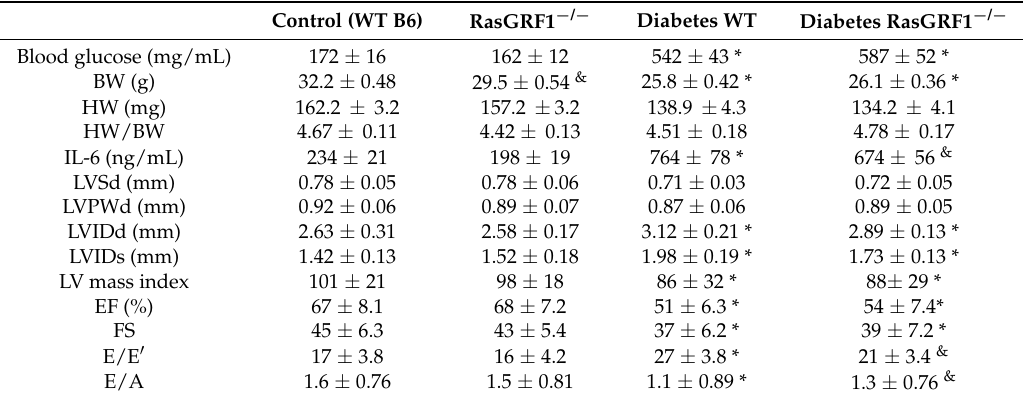
Figure 2. Morphology and cardiac function in mice as measured by cardiac echography. Representative echocardiography ( upper panel ) showed M-mode tracing. Lines indicate left ventricular septum thickness in diastole (LVSd), left ventricular posterior wall thickness in diastole (LVPWd), left ventricular internal dimension in diastole (LVIDd), left ventricular internal dimension in systole (LVIDs), and left ventricle (LV) mass. Pulse wave doppler recordings of mitral valve leaflet tips ( middle panel ) showed mitral inflow velocity patterns, and were also calculated. Representative tracings ( lower panel ) for tissue Doppler imaging of the mitral annulus septum. The E ′ wave indicated the motion of the mitral annulus during early diastolic filling of the LV, and A ′ wave indicates the atrial systole during late filling of the LV. LV: left ventricle. Table 1. Body weight, heart weight, and serum interleukin (IL)-6 levels and cardiac performance parameters measured by echocardiography.